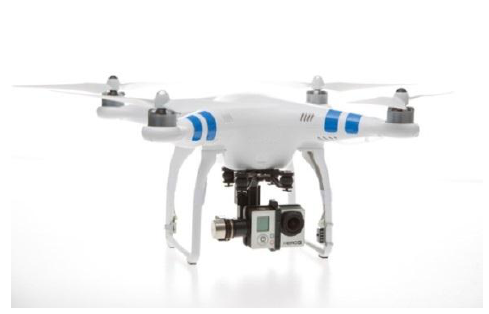
Figure 4. The DJI Phantom 2 UAV drone with GoPro